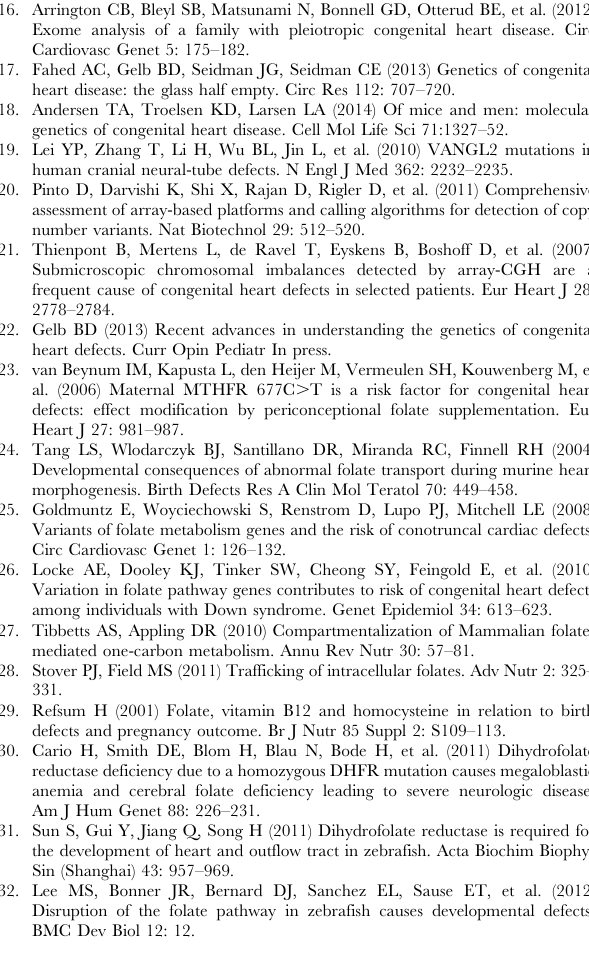
Figure S1 G-banded karyotype analysis of the twin family 1. Both individuals (Twin A and Twin B) have normal karyotypes. (TIF) Figure S2 Illumina SNP-array result of the 6p21.33 deletions in patient 894020 and patient 706346. (TIF) Table S1 Primers for Real-time Quantitative PCR